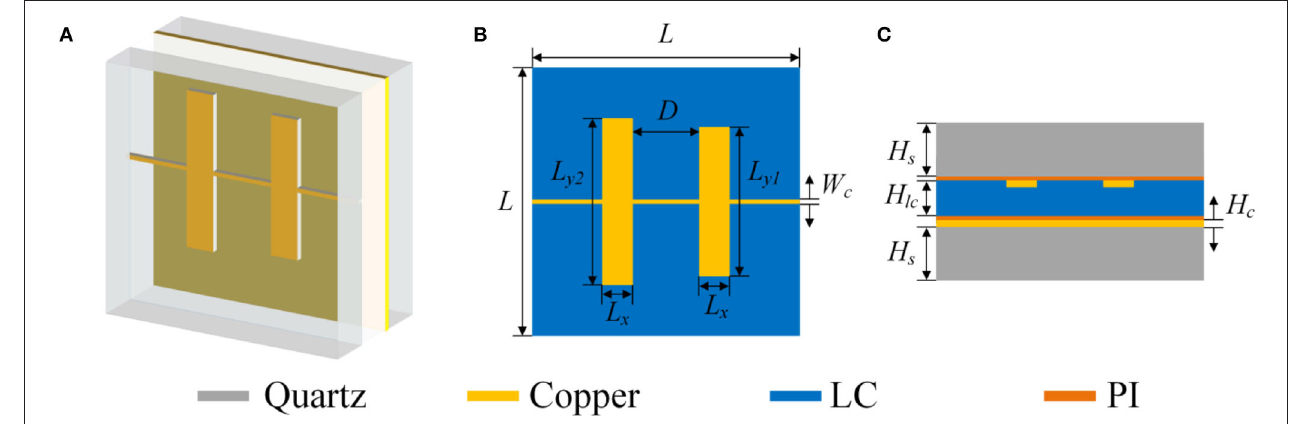
TABLE 1 | Optimized dimensions of the unit cell.